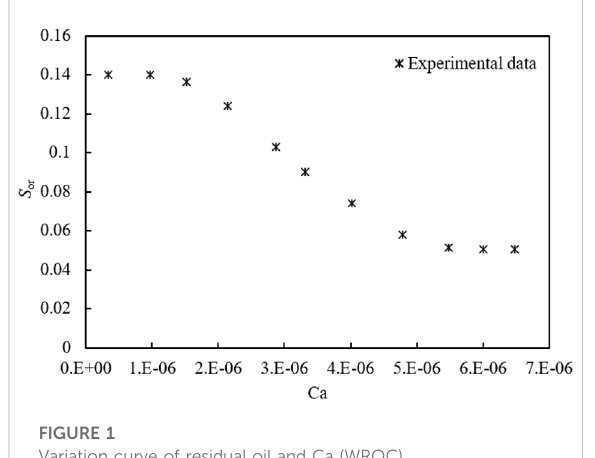
FIGURE 1 Variation curve of residual oil and Ca (WROC).